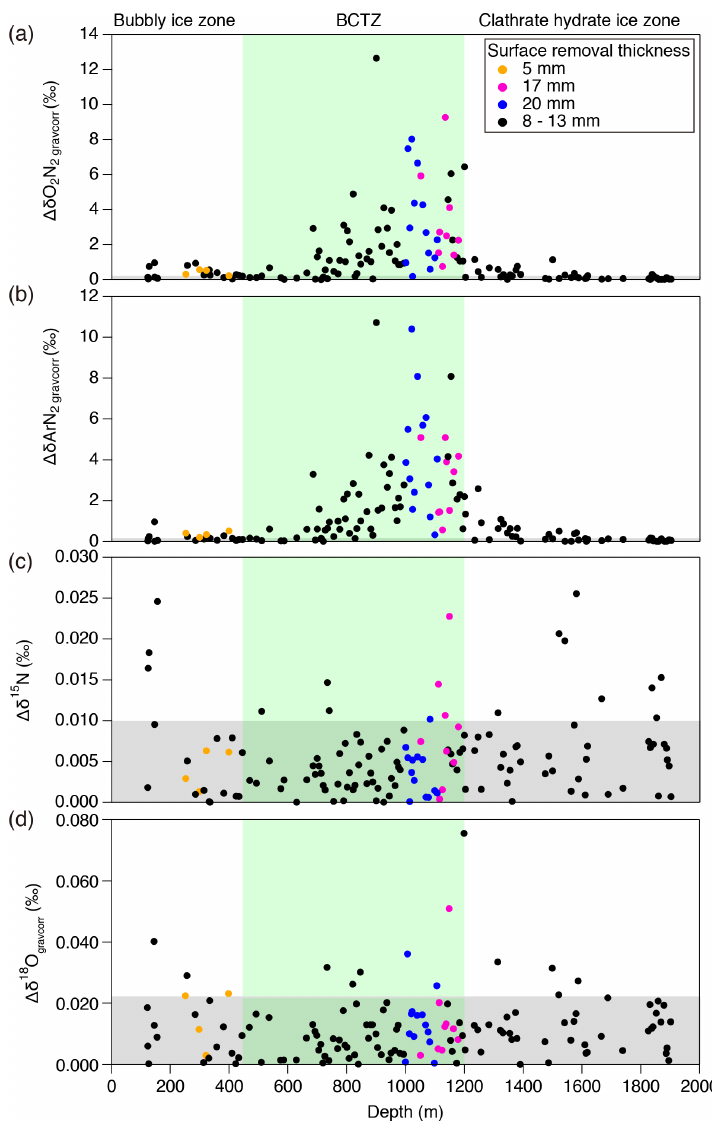
Figure B3. Absolute pair differences of (a) δ O 2 / N 2gravcorr , (b) δ Ar / N 2gravcorr , (c) δ 15 N, and (d) δ 18 O gravcorr . Gray shadings indicate 2 σ uncertainty (same as Fig.